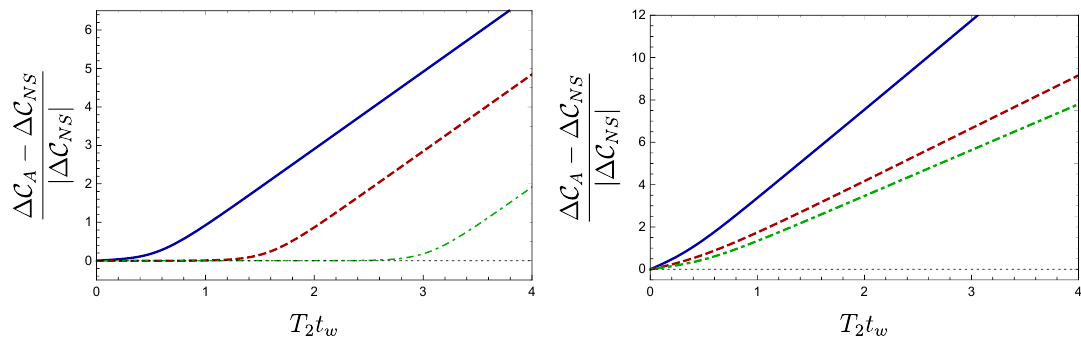
Figure 7. The complexity of formation for BTZ black holes for z = 1 =w , such that the smaller black hole is at the Hawking-Page transition, or alternatively we could normalize the complexity of formation by the entropy, which would remove the overall multiplicative factor of z , cf. eq. (3.77). In the left panel, we evaluate the complexity of formation for light shock waves as a function of T 2 t w . The energies of the shock waves are parametrized by the temperature ratio w , with w = 1 + 10 (cid:0) 1 (solid blue), w = 1 + 10 (cid:0) 4 (dashed red) and w = 1 + 10 (cid:0) 8 (dot-dashed green). For a period of time of the order of the scrambling time (3.67), the complexity of formation is approximately the same as the unperturbed state. For early shocks (i.e., larger t w ), the complexity of formation grows linearly with t w . In the right panel, we show the complexity of formation for heavier shocks, w = 4 (solid blue), w = 2 : 5 (dashed red) and w = 1 : 5 (dot-dashed green). For these parameters, we see that the complexity of formation starts changing immediately and rapidly approaches a regime of linear growth with increasing t w